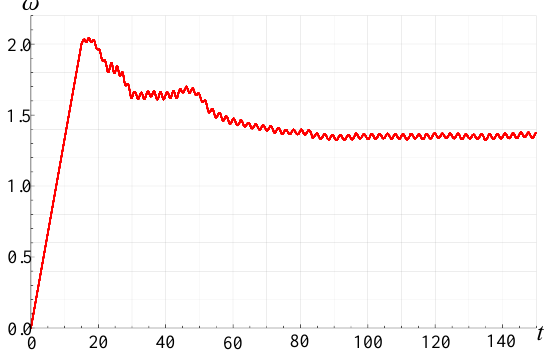
Figure 18. Angular velocity of Savonius rotor loaded with a torque M z = − 0.25.